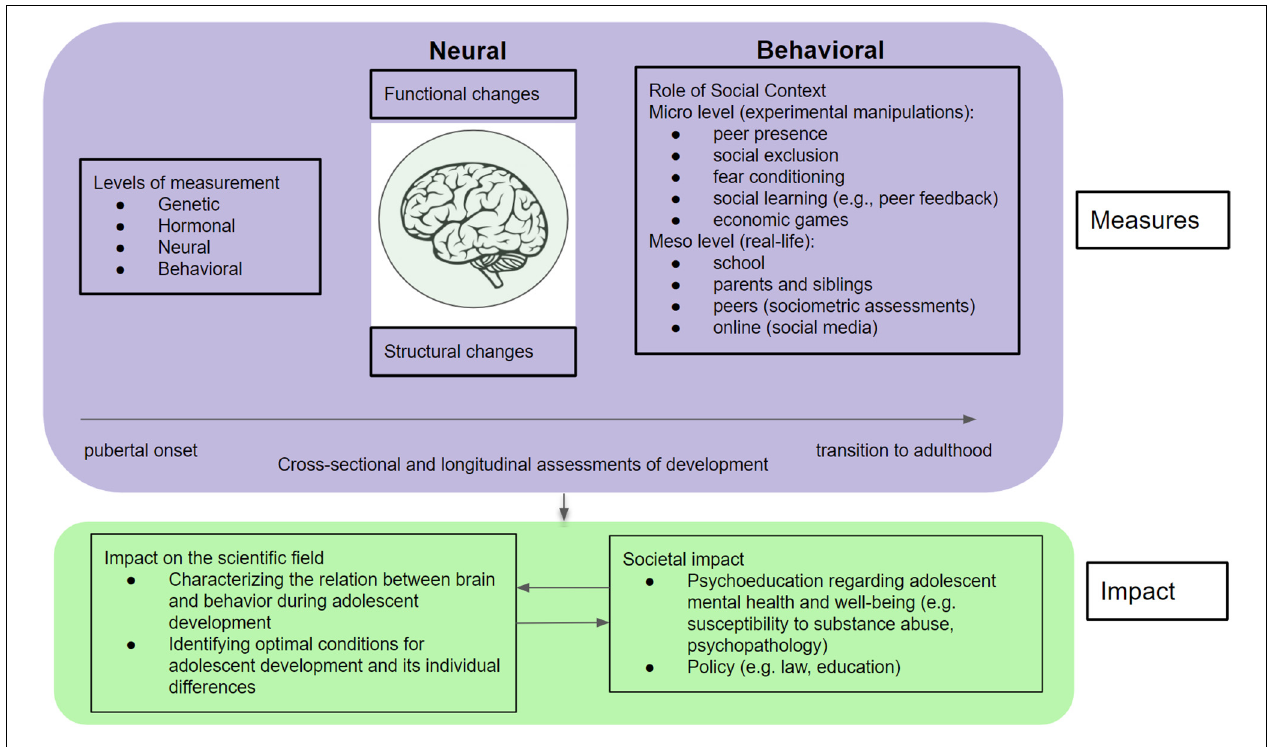
FIGURE 1 | Overview of the measures required to chart the complexity of developmental changes during adolescence and their impact. Note: This figure illustrates the richness of measures needed in studies that aim to capture the complexity of developmental changes during adolescence (purple). Findings from such studies will subsequently have a scientific and societal impact (green). Impact on the scientific field and on society are interlinked, as collaborating and communicating with societal stakeholders (e.g., policymakers, teachers, parents, and adolescents) also informs new research